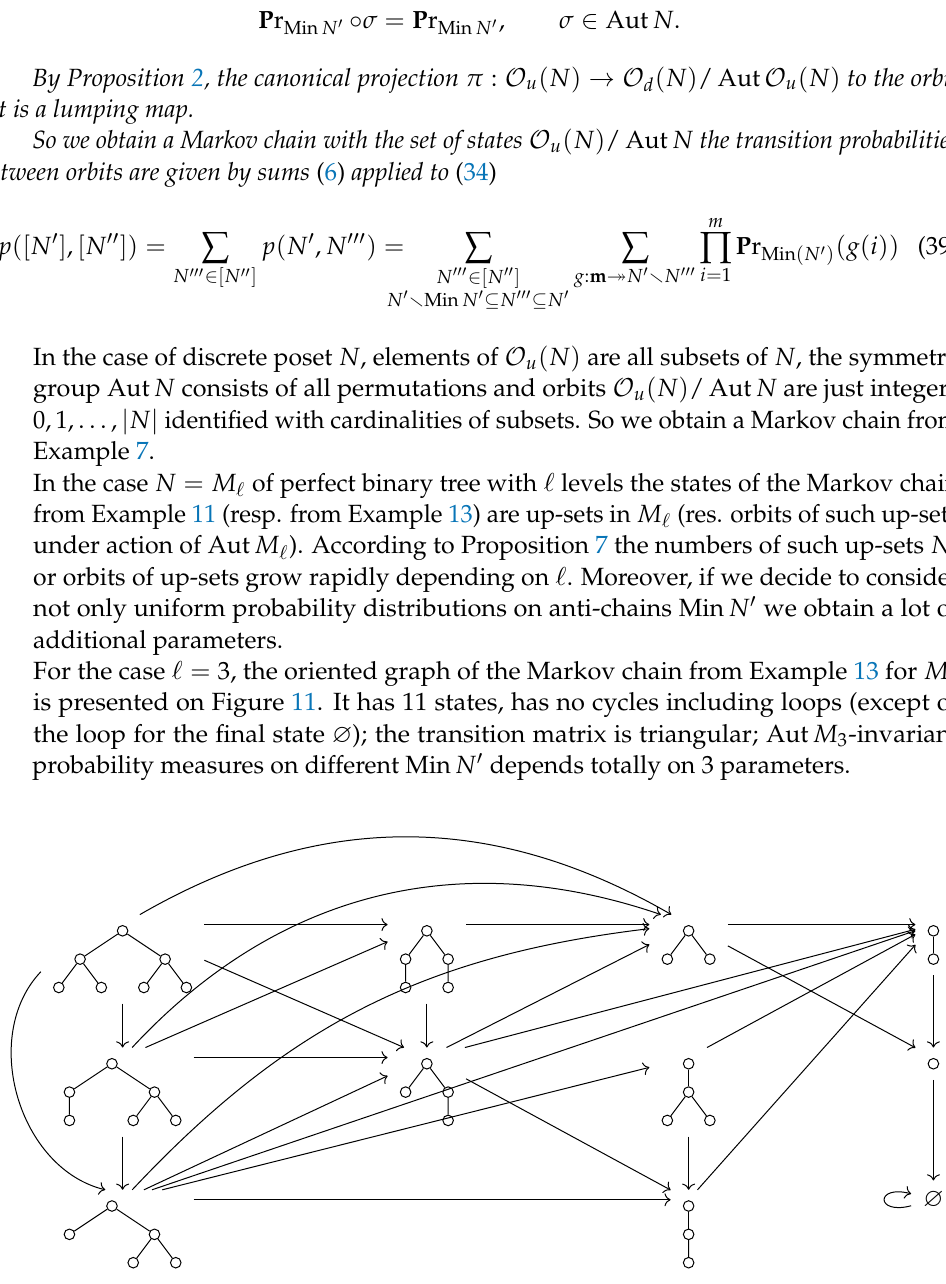
Figure 11. Markov chain for M 3 generation (factorized by Aut M 3